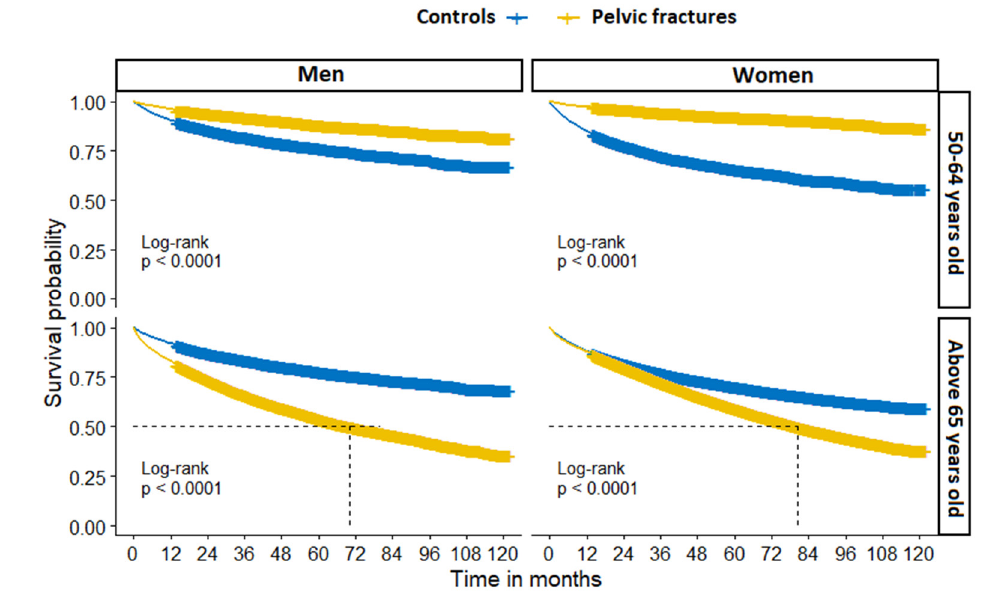
Figure 5. Overall all-cause mortality in patients with pelvic fracture and fracture-free controls, stratified by sex and age group.